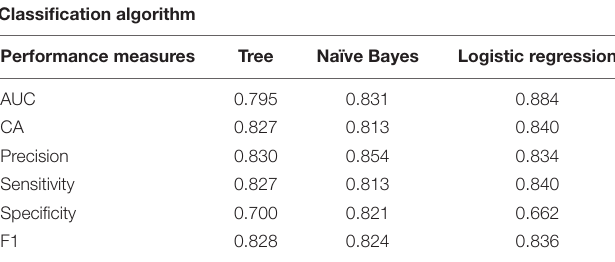
TABLE 3 | Performance of the three classification algorithms.